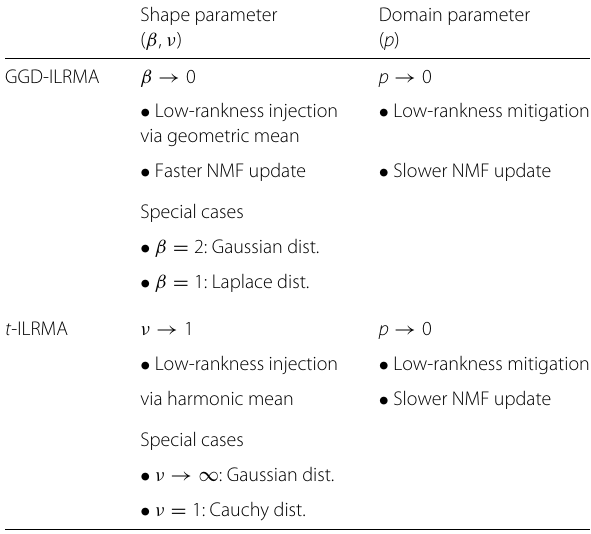
Table 1 Summary of parameterized properties in GGD- and t -ILRMA Shape parameter Domain parameter ( β , ν )